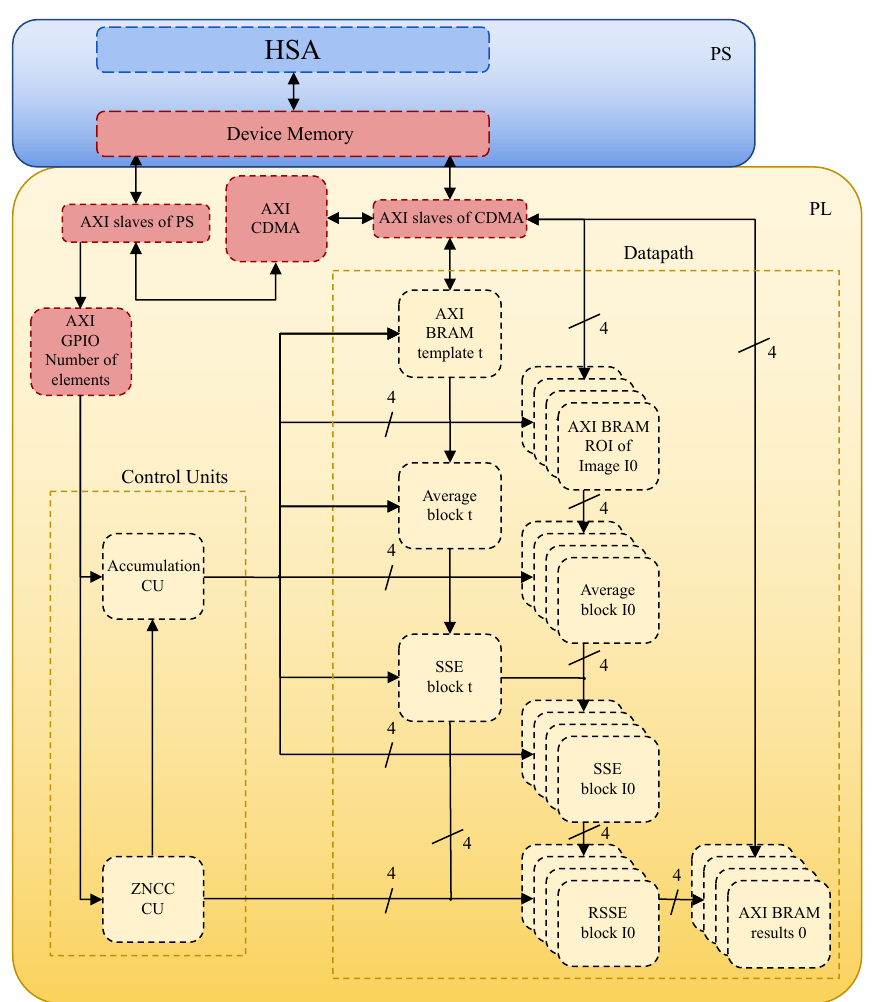
Figure 7. An illustration of the final interconnection of the ZNCC processing unit’s top-level blocks. Average blocks, SSE blocks, RSSE blocks, the accumulation CU, and the ZNCC CU are the key blocks that were implemented utilizing the PL. The communication between PS and PL is implemented using AXI, where CDMA is used to transfer image data and GPIO is used to transfer simple control